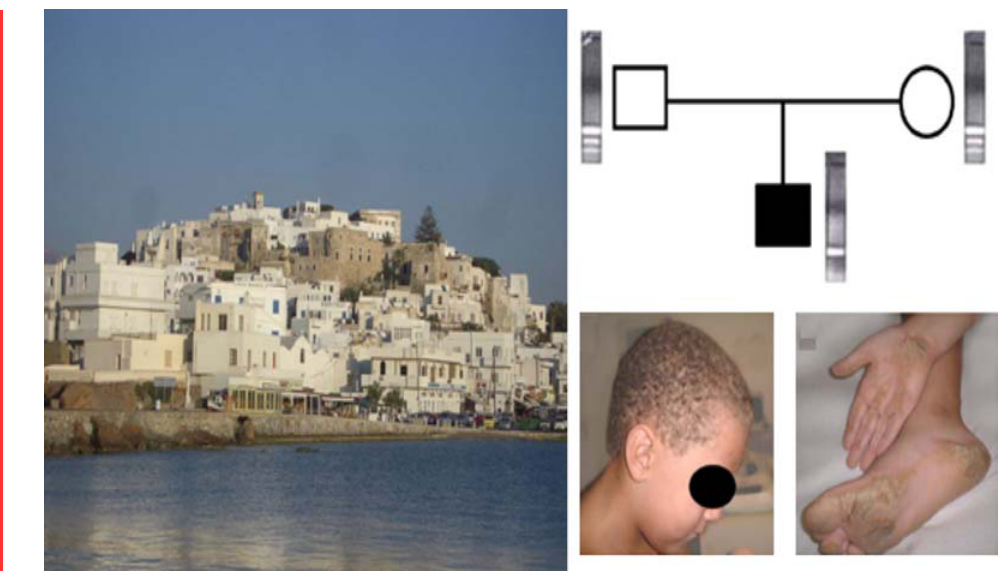
Figure 2. Clockwise from left: The Greek island of Naxos. A nuclear Naxos disease family. Analysis reveals the presence of a mutant allele (one bold band) in the homozygous boy and the wild-type (two light bands) coexisting with the mutant allele in the heterozygous carrier parents. Classic symptoms of Naxos disease, keratoderma striate in palmar and diffuse in plantar areas in the homozygous boy and wooly hair